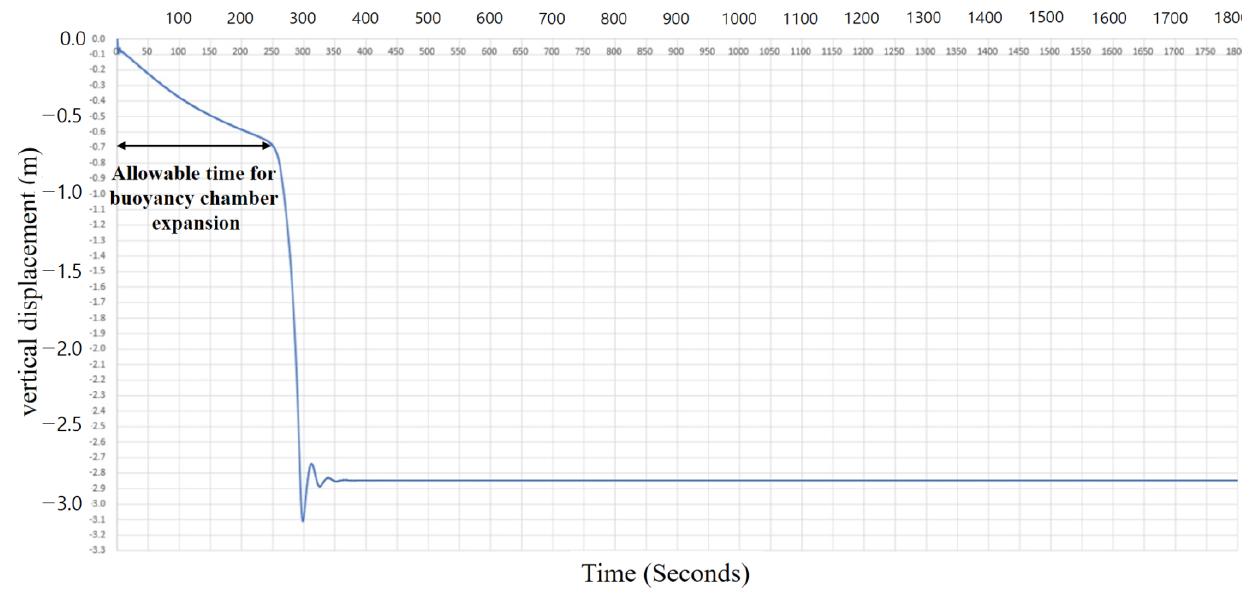
Figure 7. The results of the simulation of flooding due to damage to areas No. 1 and No. 2 void, sinking after 4.3 min (263 s).